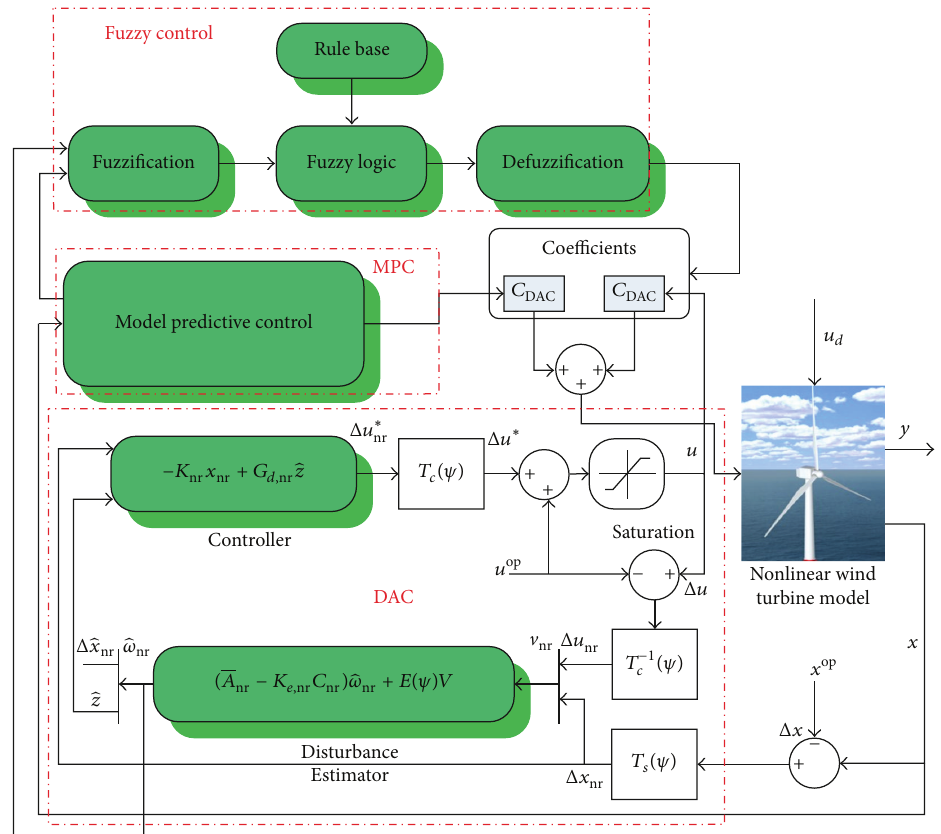
Figure 3: Block diagram of the overall control scheme.